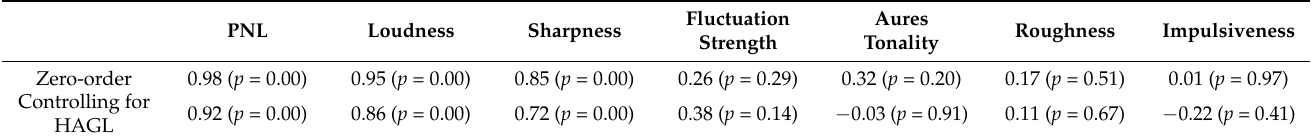
Table 5. Zero-order and partial correlation coefficients (controlling for height above ground level (HAGL)) between PNL and the SQMs (loudness, sharpness, fluctuation strength, Aures tonality, roughness and impulsiveness) and perceived loudness. p -value shown in brackets.